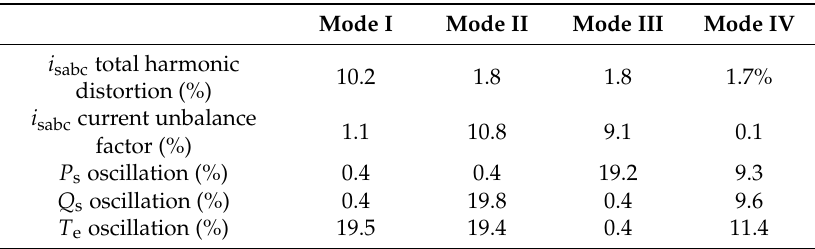
Table 2. Comparisons among different modes during network unbalance.